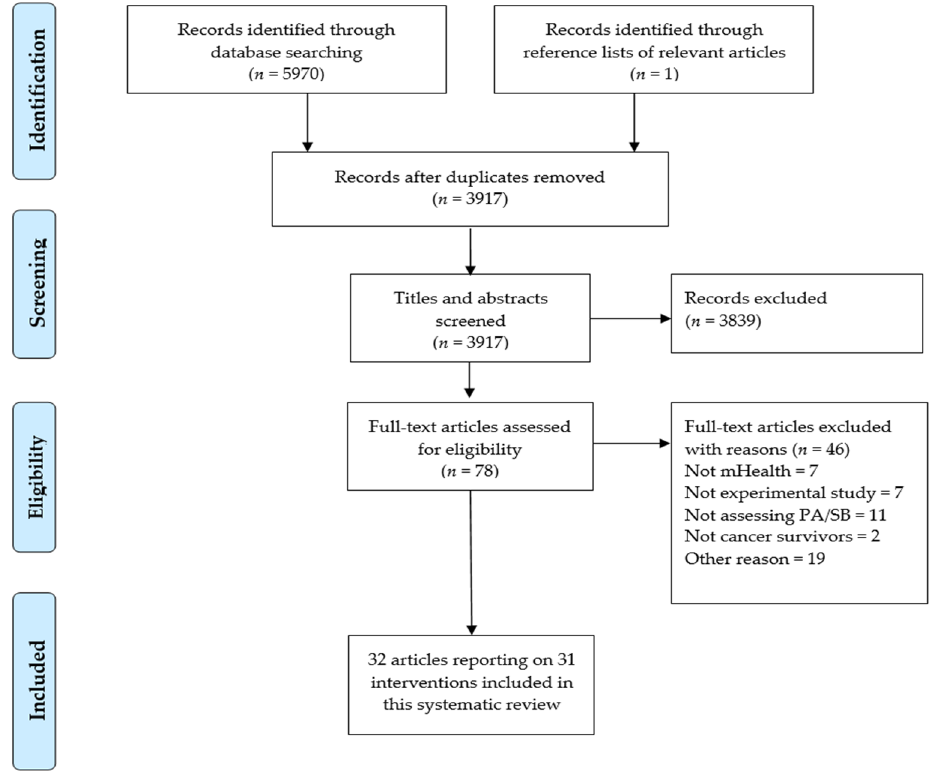
Figure 1. PRISMA diagram illustrating the flow of records.